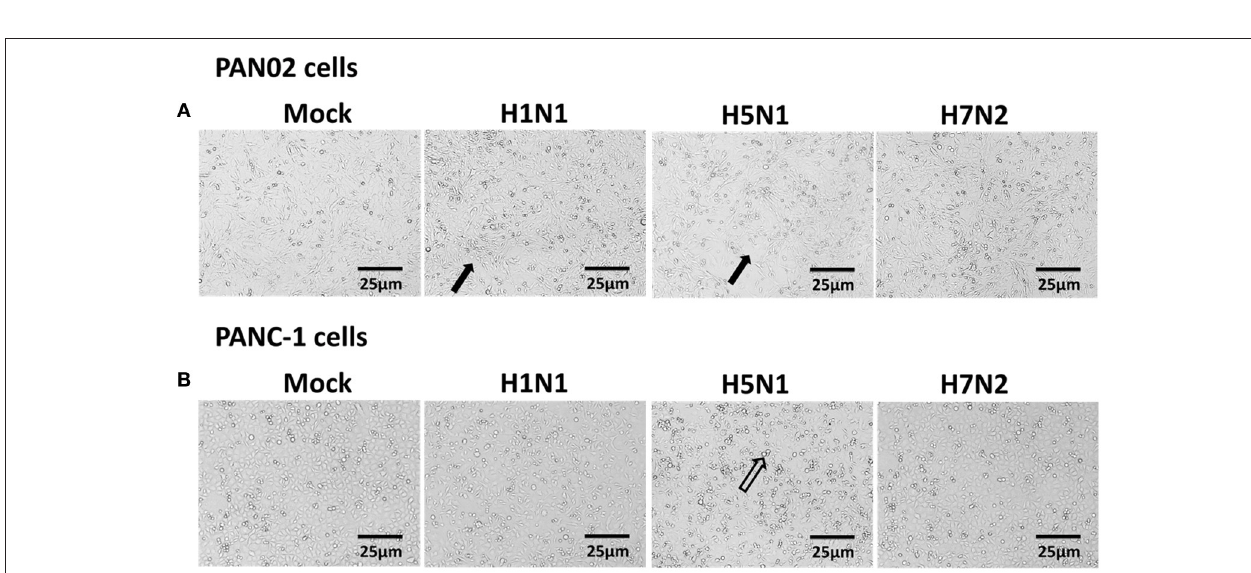
FIGURE 4 | H5N1 IAV could infect pancreatic cells in vivo . Representative pancreas sections from control or IAV-infected mice. (A) Sections were analyzed by H & E staining. Black arrows indicate hemorrhage. Hollow arrows indicate necrosis of pancreatic cells. Triangles indicate dilatation and exudate in pancreatic duct. (B) Sections were analyzed by IHC staining. Black arrows indicate positive signals.